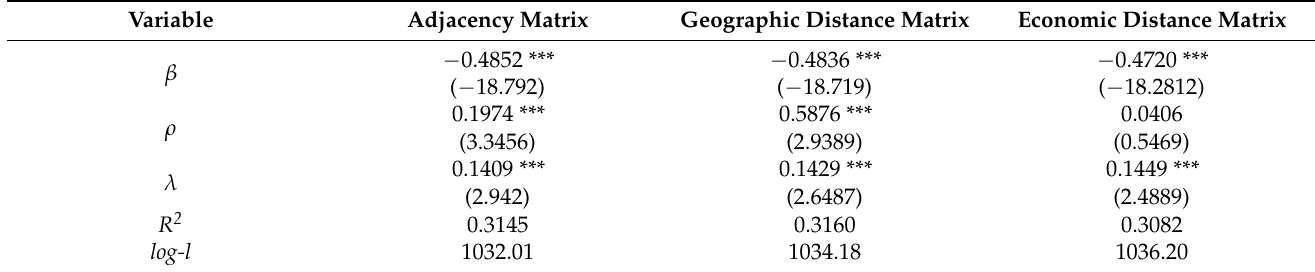
Table 6. Absolute β -convergence estimation results.